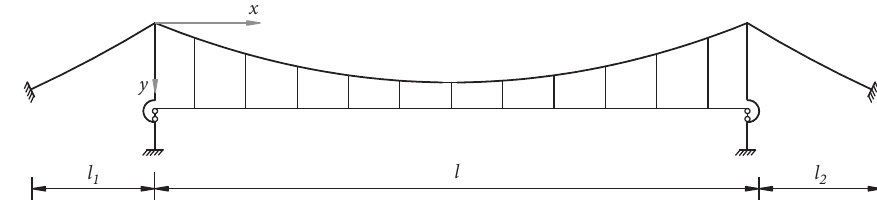
Figure 9: Geometry and coordinate system of a single-span suspension bridge.